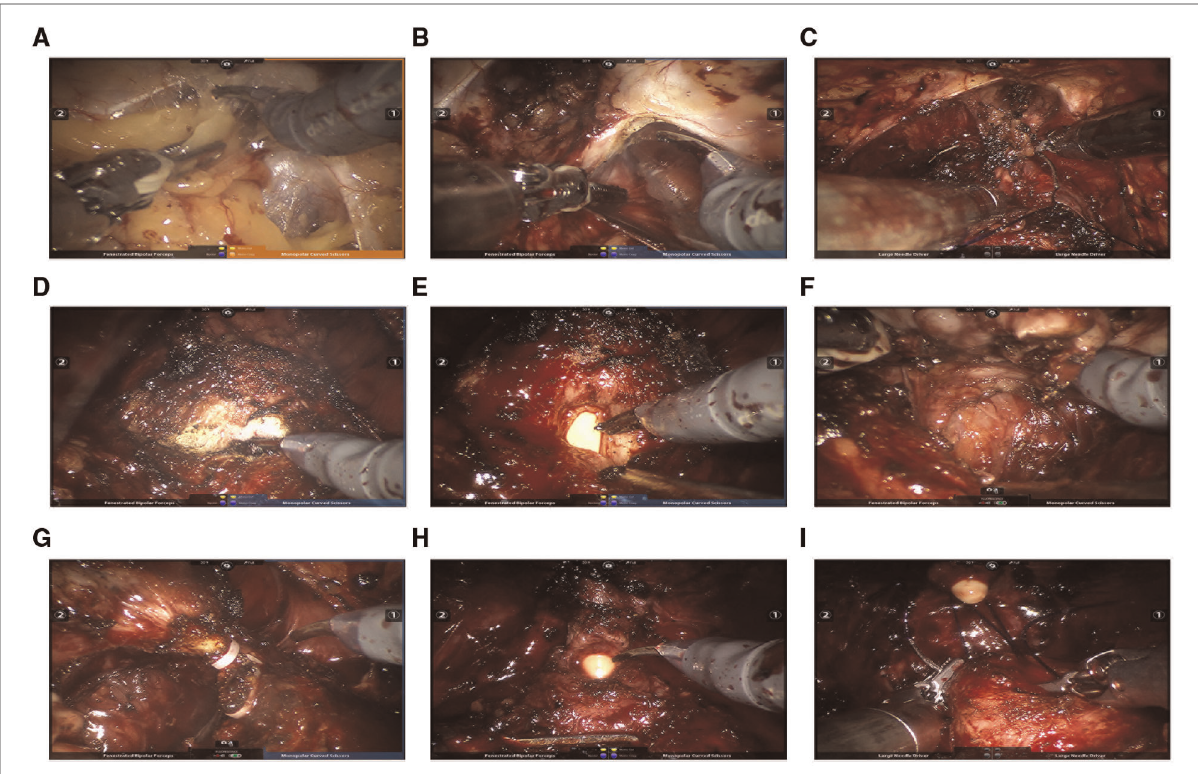
FIGURE 3 Intraoperative images illustrating key steps for ssmpRARP: ( A ) Creating an extraperitoneal working space; ( B ) Incising pelvic fascia of both sides; ( C ) Ligating and transecting the dorsal vascular complex; ( D ) Bladder neck dissection; ( E ) Dissecting the prostatic base and transecting the bladder neck; ( F ) Dissecting seminal vesicles and the posterior prostatic plane (Denonvilliers fascia). ( G ) Dissecting the prostatic pedicle (right); ( H ) Dissecting the apex of the prostate and transecting the urethral; ( I ) Performing vesicourethral